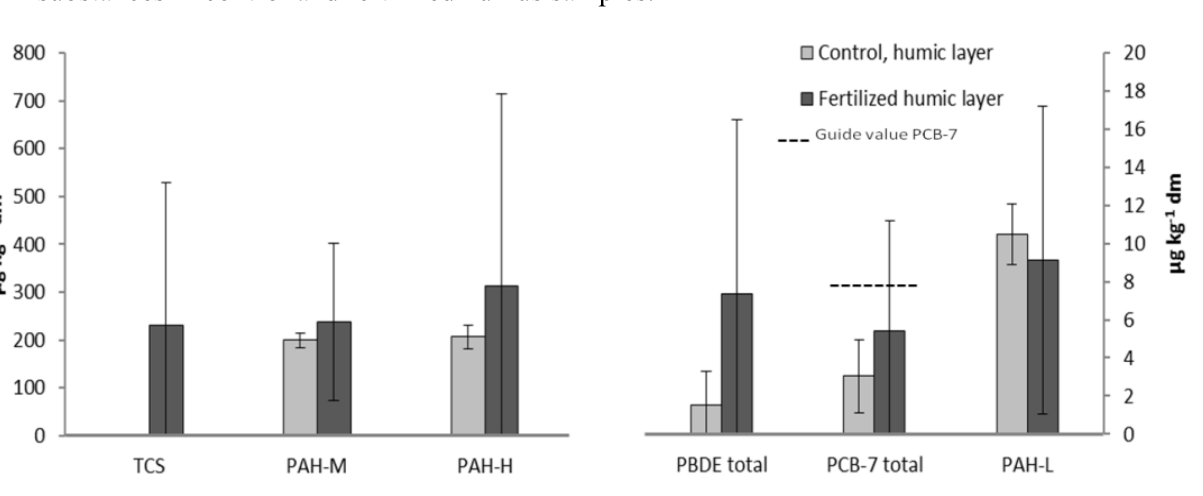
Figure 5. Average concentrations and standard deviations of the synthetic organic substances in control and fertilized humus